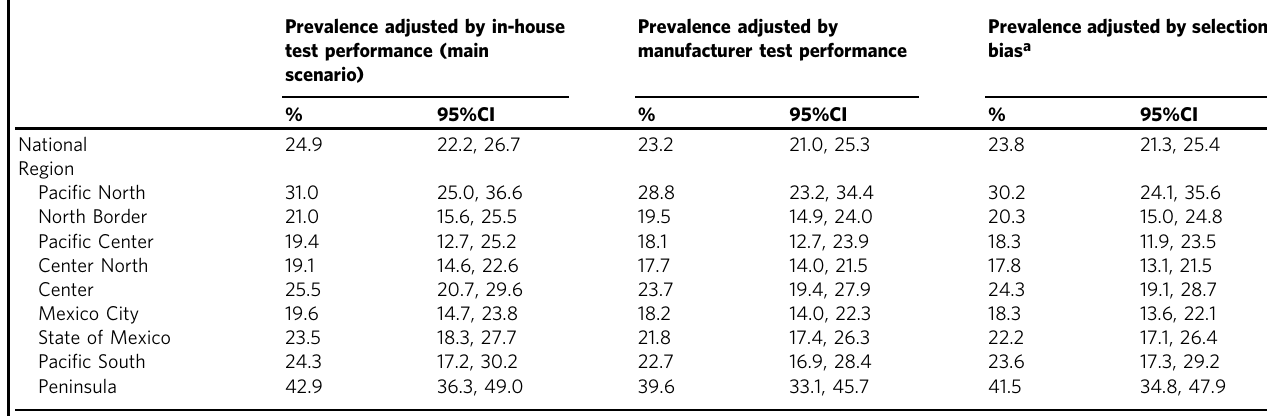
Table 3 Sensitivity analysis for the seroprevalence of antibodies SARS-CoV-2 in Mexico, by regions. Ensanut 2020 COVID-19. Prevalence adjusted by Prevalence adjusted by in-house manufacturer test test performance (main